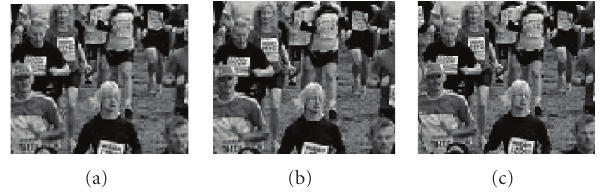
Figure 7: ROI disabled (a), ROI enabled with Δ QF = 35 (b), and ROI enabled with Δ QF = 70 (c) for Crowd Run sequence using MJPEG.